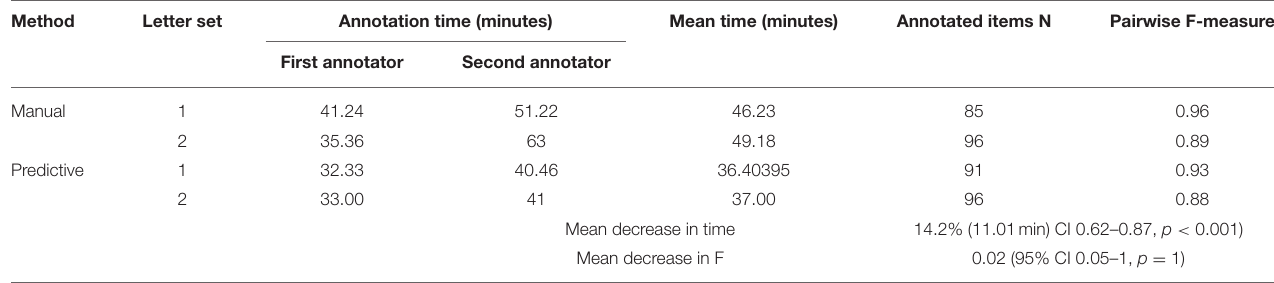
TABLE 2 | Comparing manual and predictive